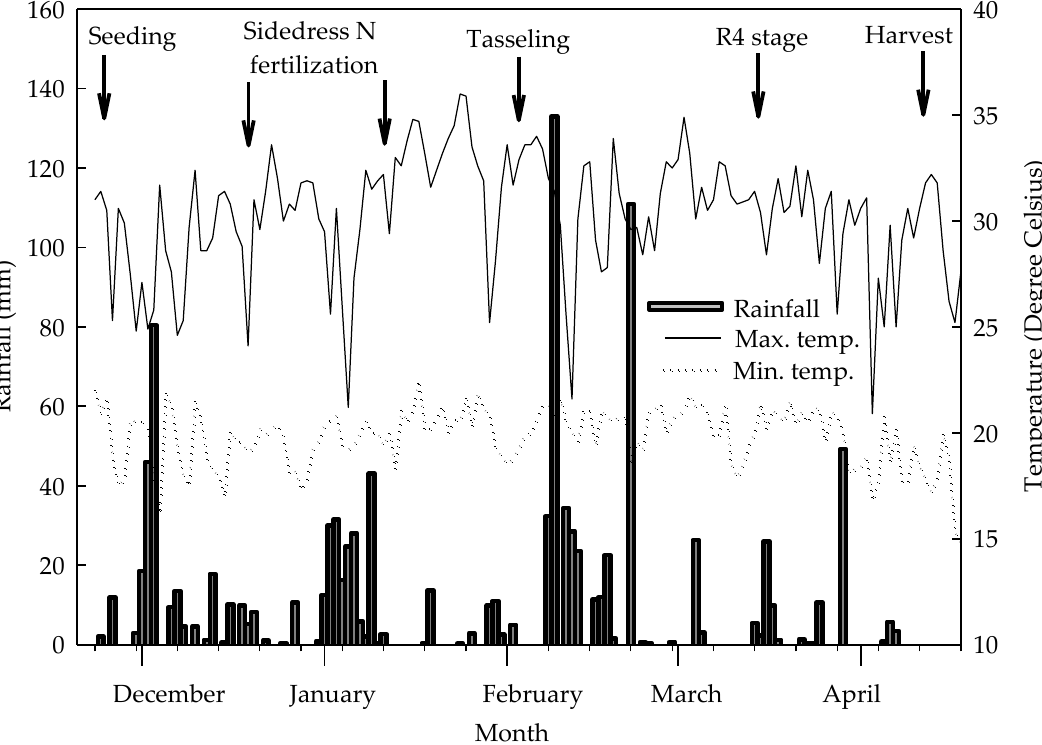
Figure 1. Rainfall, maximum temperature (Max. temp.), and minimum temperature (Min. temp.) during the assay development, as well as indications date of seeding, N fertilization, tasseling, R4 stage, and final harvest.